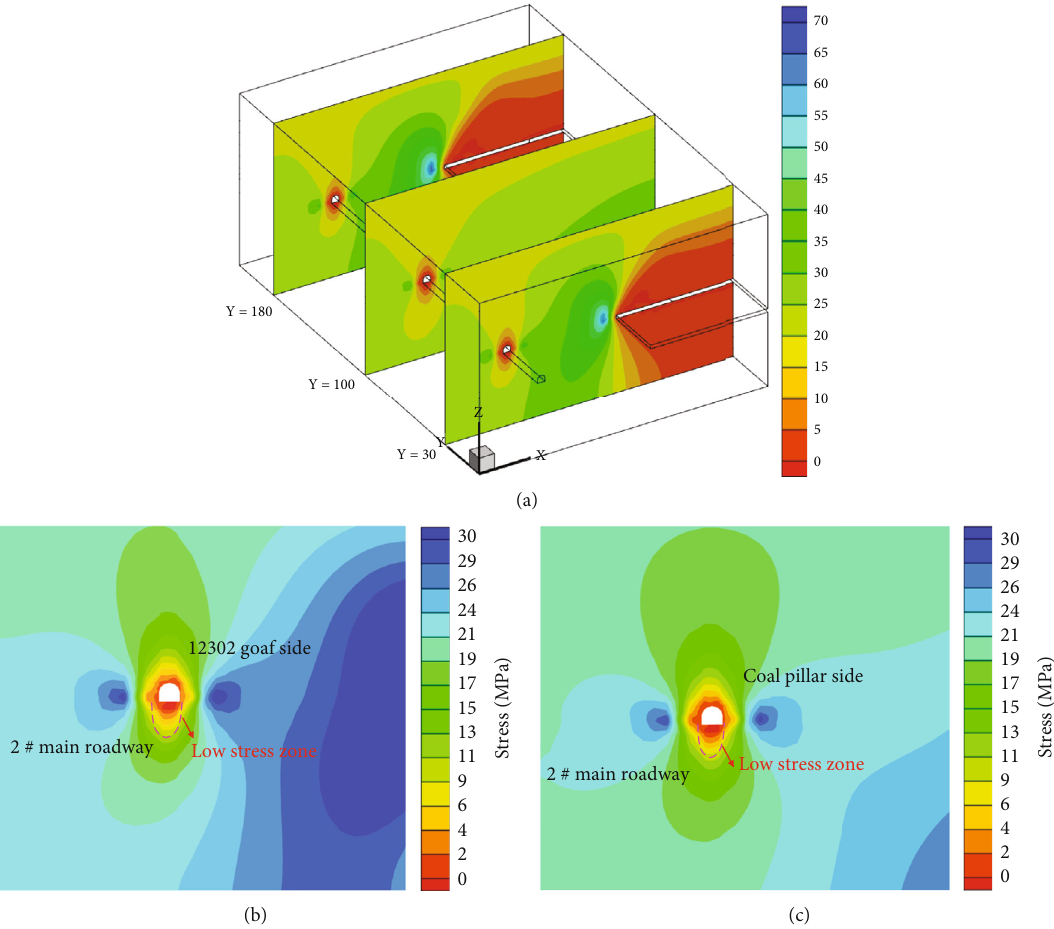
Figure 9: Vertical stress distribution. (a) Stress distribution at di ff erent positions of roadway. (b) Y = 30 . (c) Y = 100